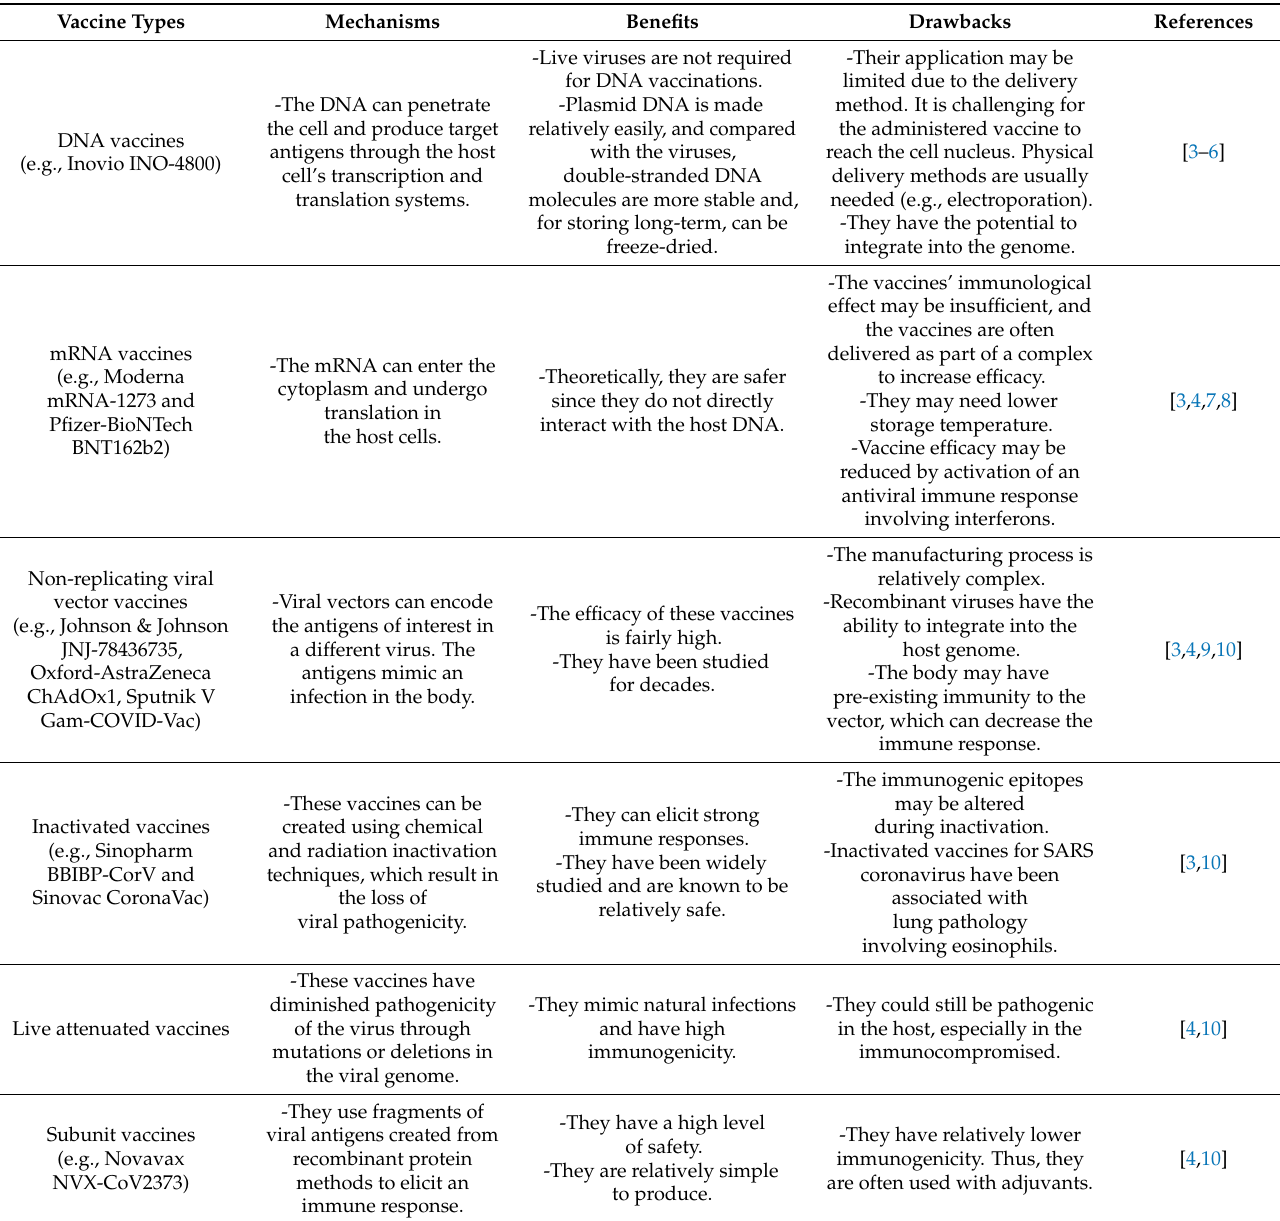
Table 1. Some of the benefits and drawbacks of various vaccine